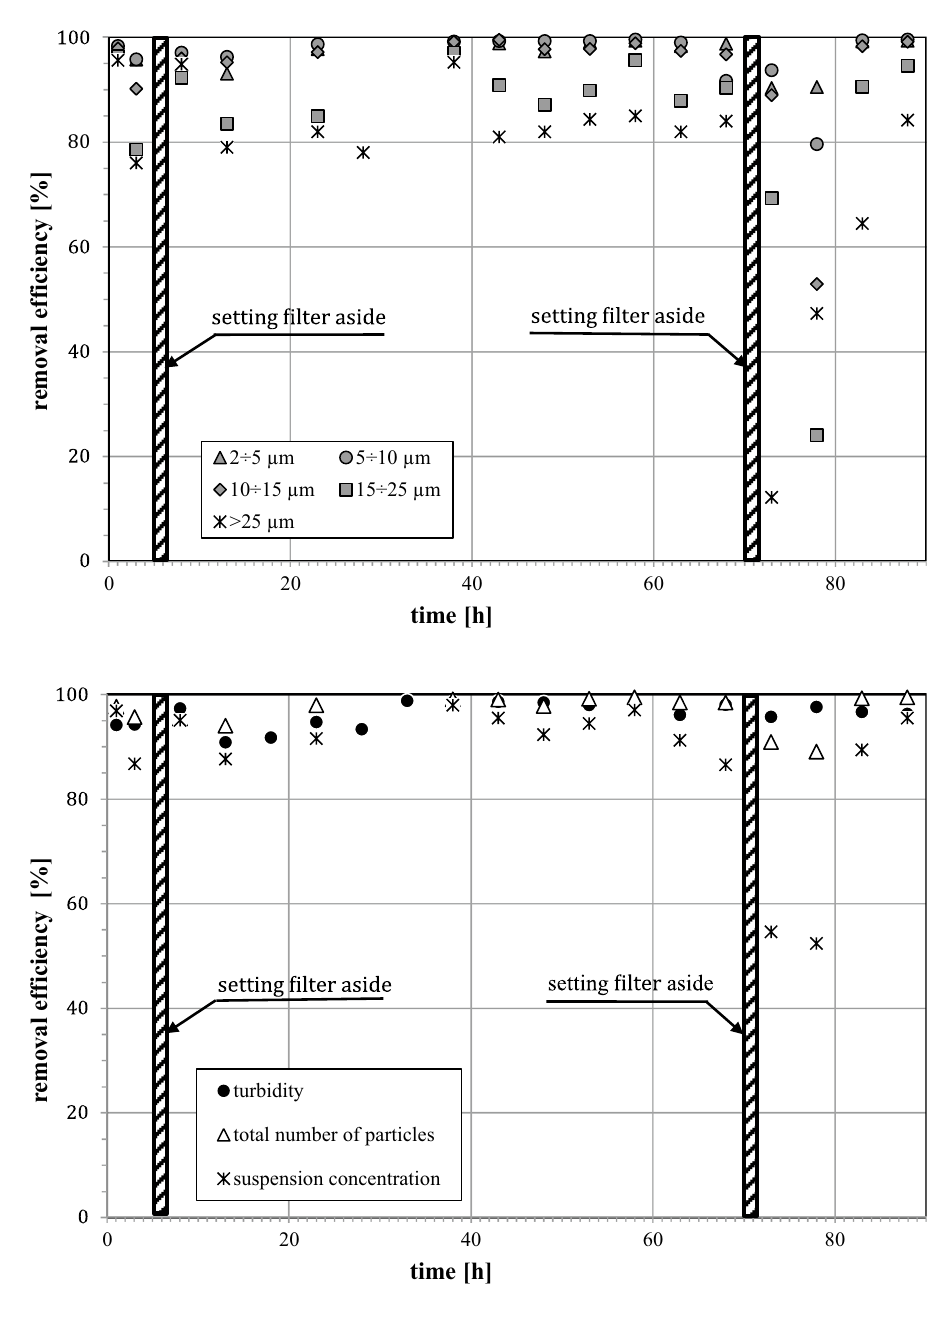
Fig. 2 Efficiency of removing particles from particular size groups